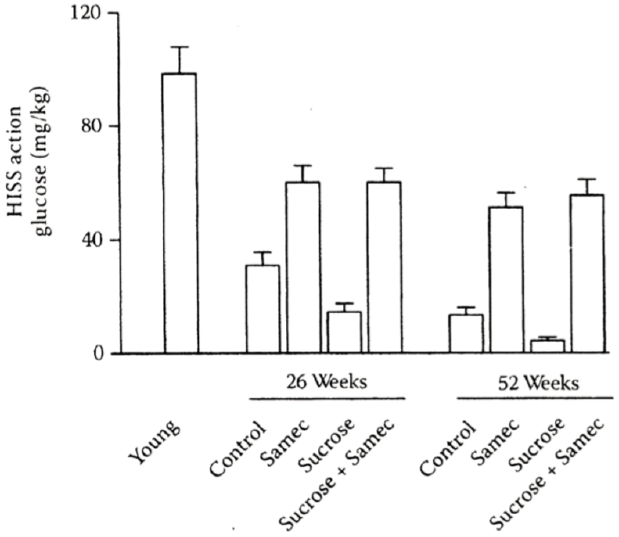
Figure 8. Interaction of age, sucrose, and antioxidants on HISS action. HISS-dependent insulin action assessed from the RIST index decreases with age in rats (young refers to 9 weeks of age) and is exacerbated by a low-dose (5%) sucrose supplement. The antioxidant cocktail, Samec, attenuates the decline in HISS action resulting from age and completely prevents the impact of sucrose. Results were recalculated from the pooled data of Lautt et al. 2008 [59] and Ming et al. 2009 [48,61].